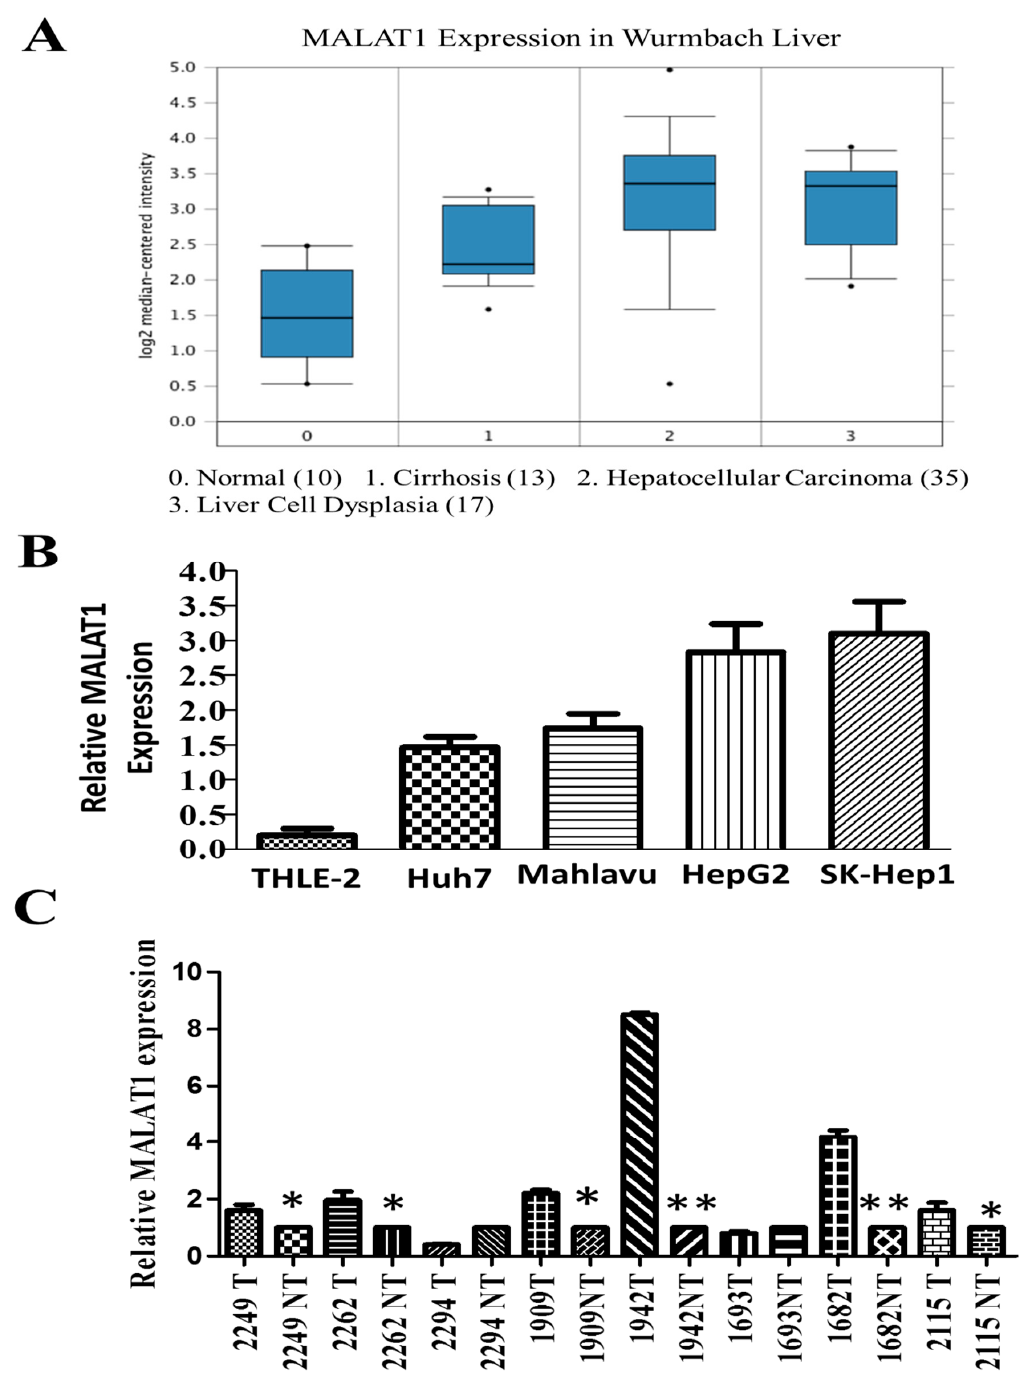
Figure 1. LncRNA MALAT1 is over-expressed in liver cancer tissues and cell lines. ( A ) Di ff erential MALAT1 expression in HCC (n = 35, median 3.352) followed by liver cell dysplasia (n = 17, median 3.32), cirrhosis (n = 13, median 2.21) and normal liver (n = 10, median 1.456) from analyses of the Oncomine Wurmbach liver dataset. 0 = Normal; 1 = cirrhosis; 2 = hepatocellular carcinoma; 3 = liver cell dysplasia. ( B ) Graphical representation of relative MALAT1 mRNA expression levels in normal liver cell line THLE-2, HCC Huh7, Mahlavu, SK-Hep1 and HepG2 human hepatoblastoma cell lines. U6 served as internal control. ( C ) Comparative analyses in paired clinical HCC and non-tumor liver samples using quantitative PCR method. * p < 0.05, ** p < 0.01; T, tumor; NT,